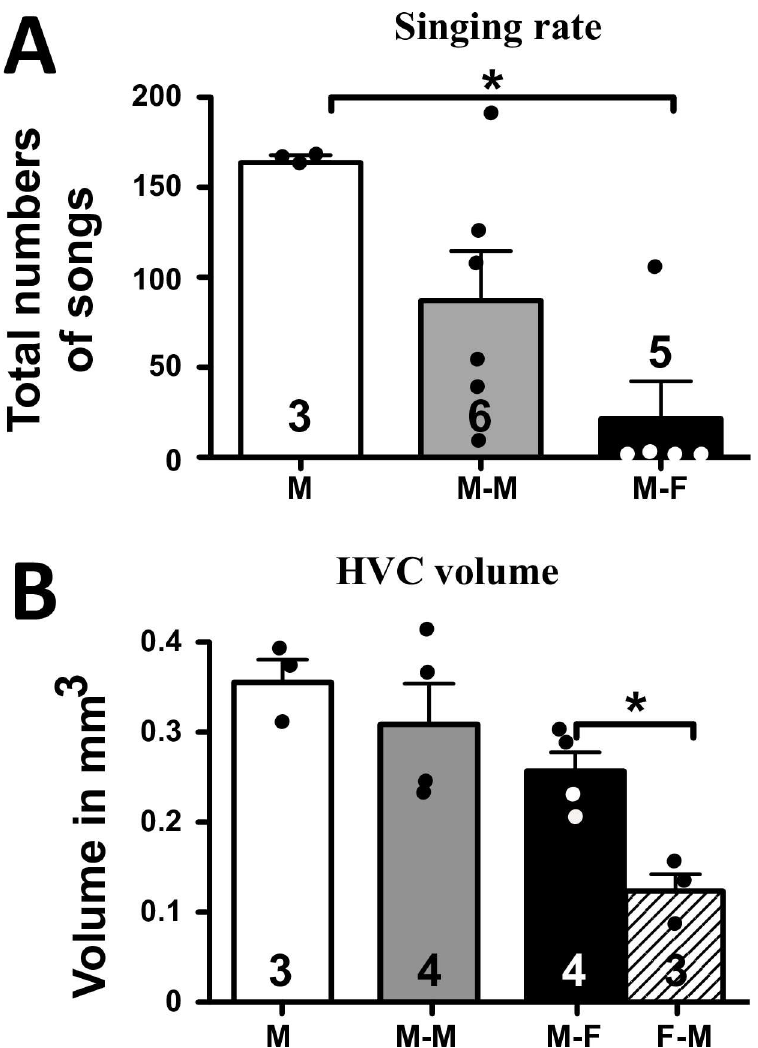
male-alone, M-F: male housed with female, M-M: male housedwith another male, F-M: female housed with a male. The figures on the bars indicatethe numbersof availabledata. * = p <